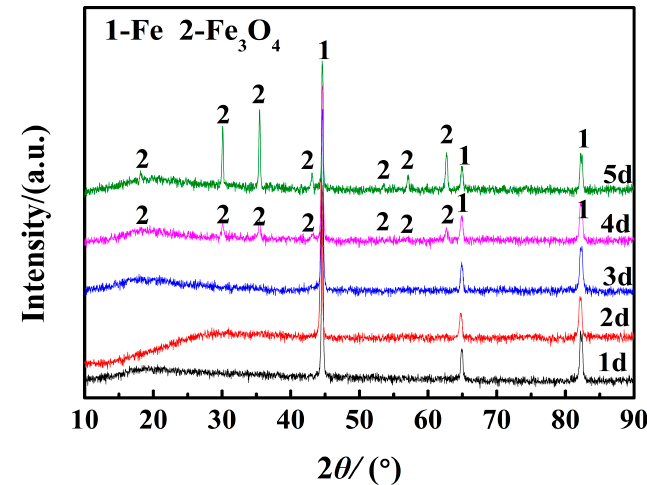
Figure 3. XRD patterns of 12Cr1MoV steel corroded for different times at 110 °C in the TCSA